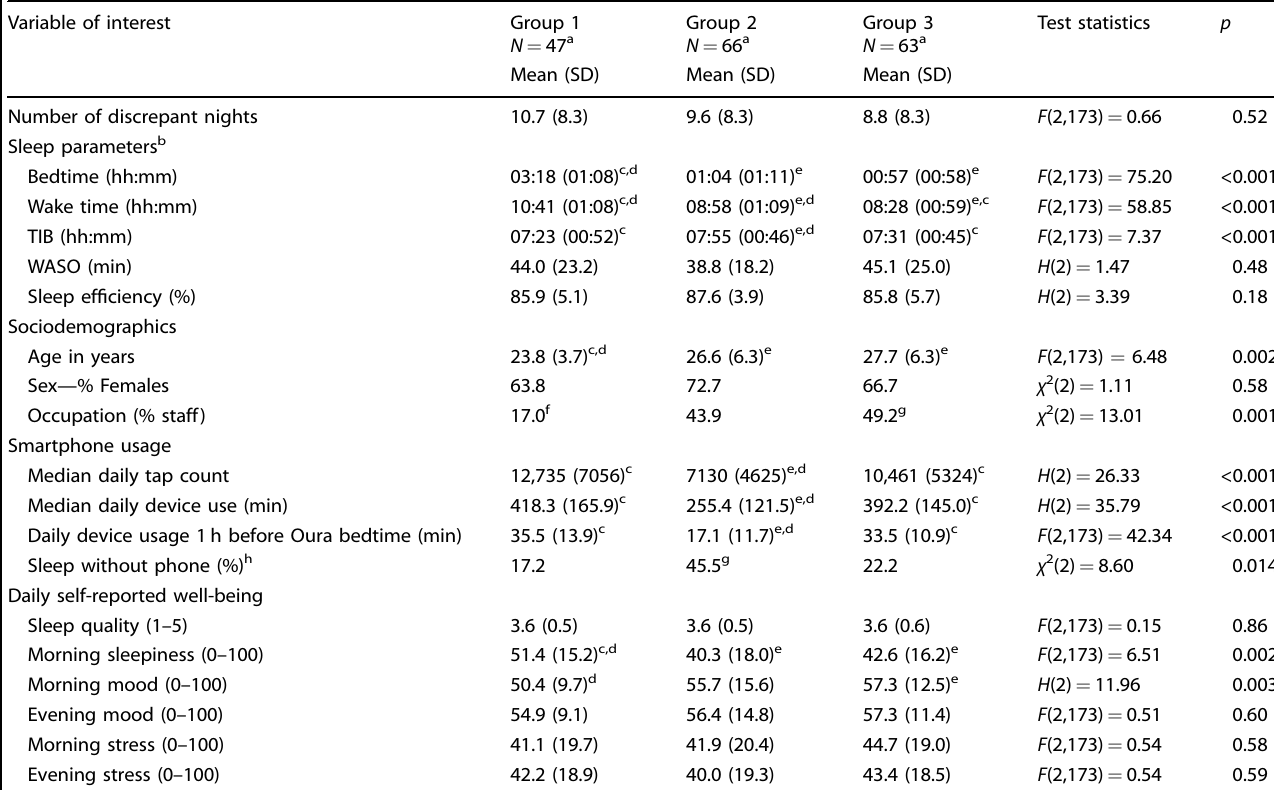
Table 3. Comparing groups on sleep, sociodemographic, smartphone usage, and daily well-being. Variable of